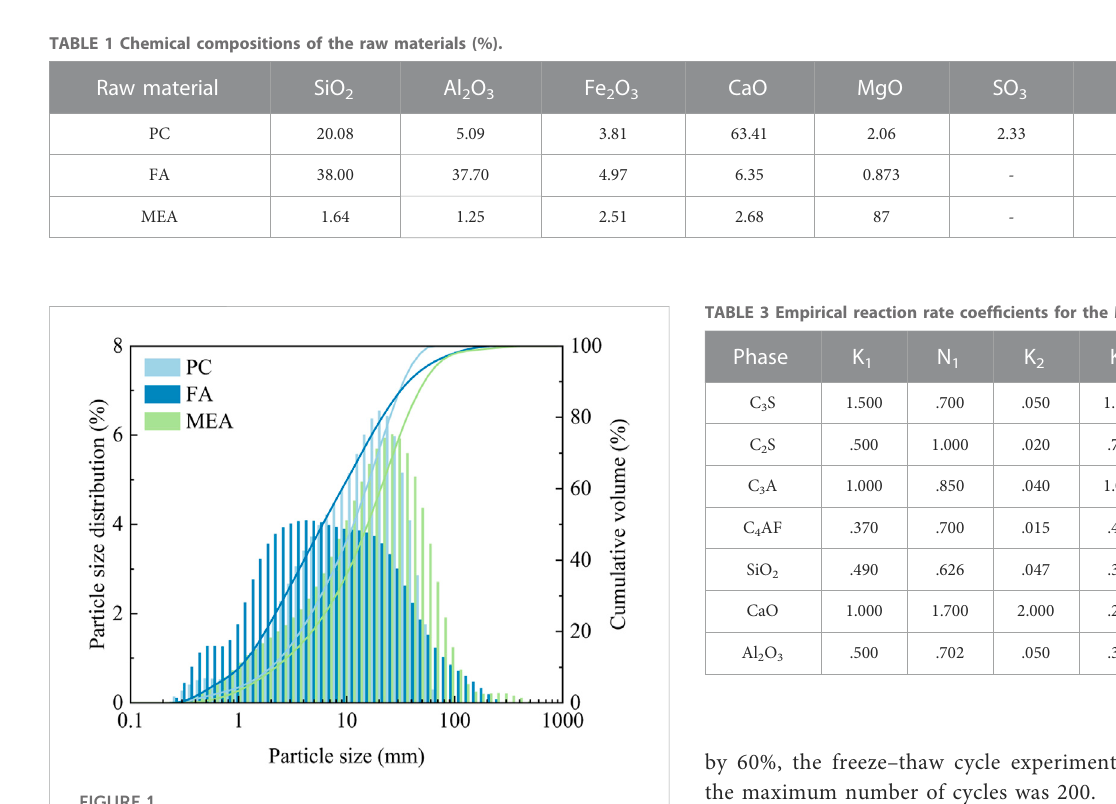
FIGURE 1 Particle size distributions of the raw materials.